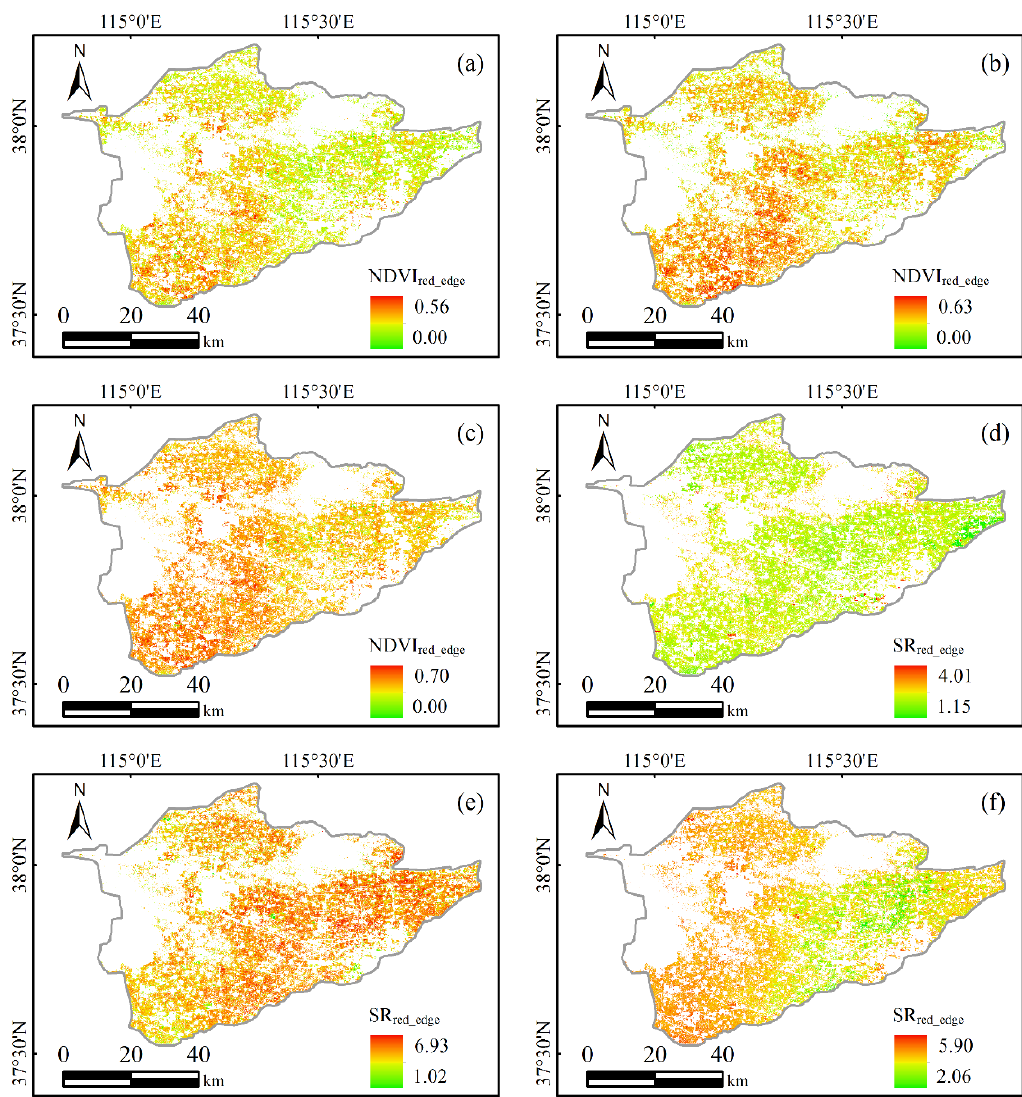
Figure 7. The spatial distribution of the red-edge vegetation indices of crops in the main growing season. ( a – c ) Spatial distribution of NDVI red-edge of winter wheat from March to May. ( d – f ) Spatial distribution of SR red-edge of maize from July to September.